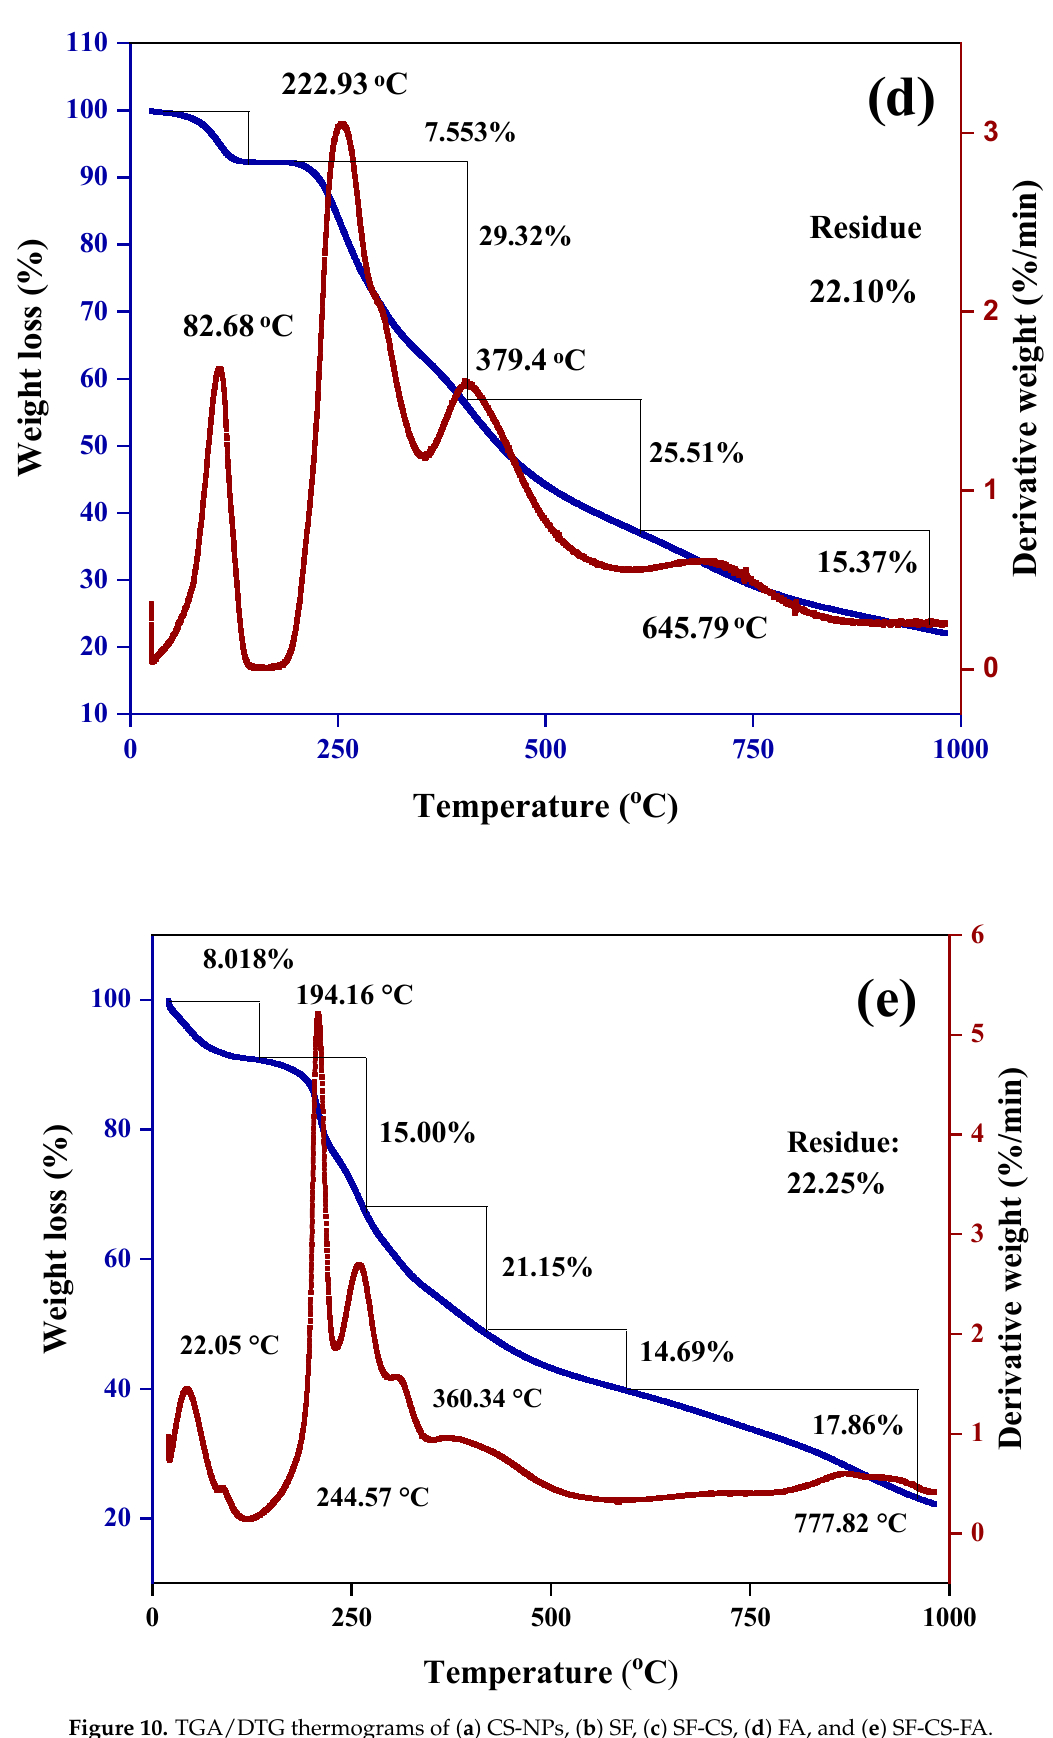
Figure 10. TGA/DTG thermograms of ( a ) CS-NPs, ( b ) SF, ( c ) SF-CS, ( d ) FA, and ( e ) SF-CS-FA.